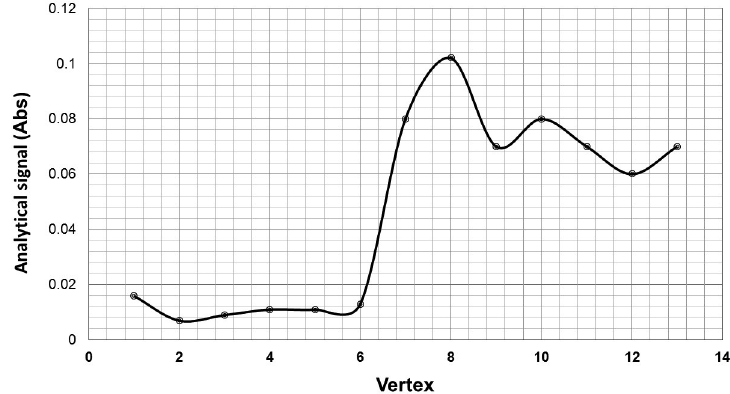
Figure 4 - Evolution of the analytical signal in diverse conditions for each vertex of the triangle de fi ned by the simplex method